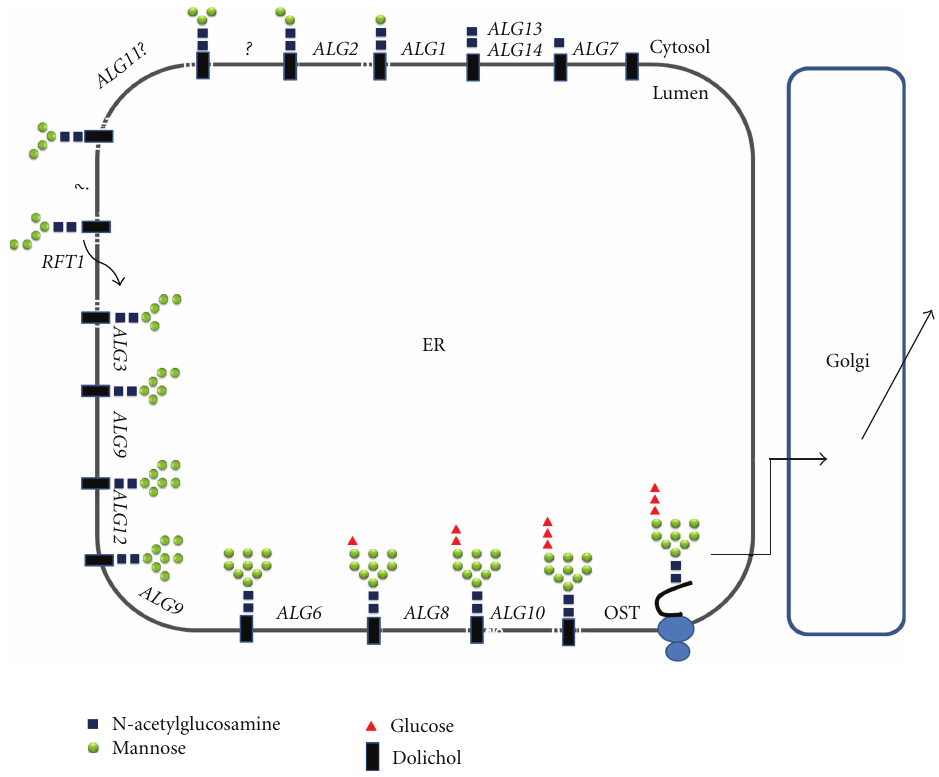
Figure 1: Biosynthesis of the lipid-bound oligosaccharide and transfer of the oligosaccharide to the nascent polypeptide in the endoplasmic reticulum of S. cerevisiae . The identified ALG genes for the respective glycosylation reactions are indicated. Synthesis starts at the cytoplasmic face with UDP-GlcNAc and GDP-Man as donors. The Man 5 GlcNAc 2 -PP-Dol is then transferred to the luminal side with the help of Rft1 and elongated to the full-length lipid-linked oligosaccharide Glc 3 Man 9 GlcNAc 2 -PP-Dol by using Dol-P-Man and Dol-P-Glc as donors. The oligosaccharide is subsequently transferred to the γ -amido group of the asparagine residues within the consensus sequence Asn-X-Ser/Thr of nascent secretory proteins. This reaction is catalyzed by the oligosaccharyltransferase (OST) complex.